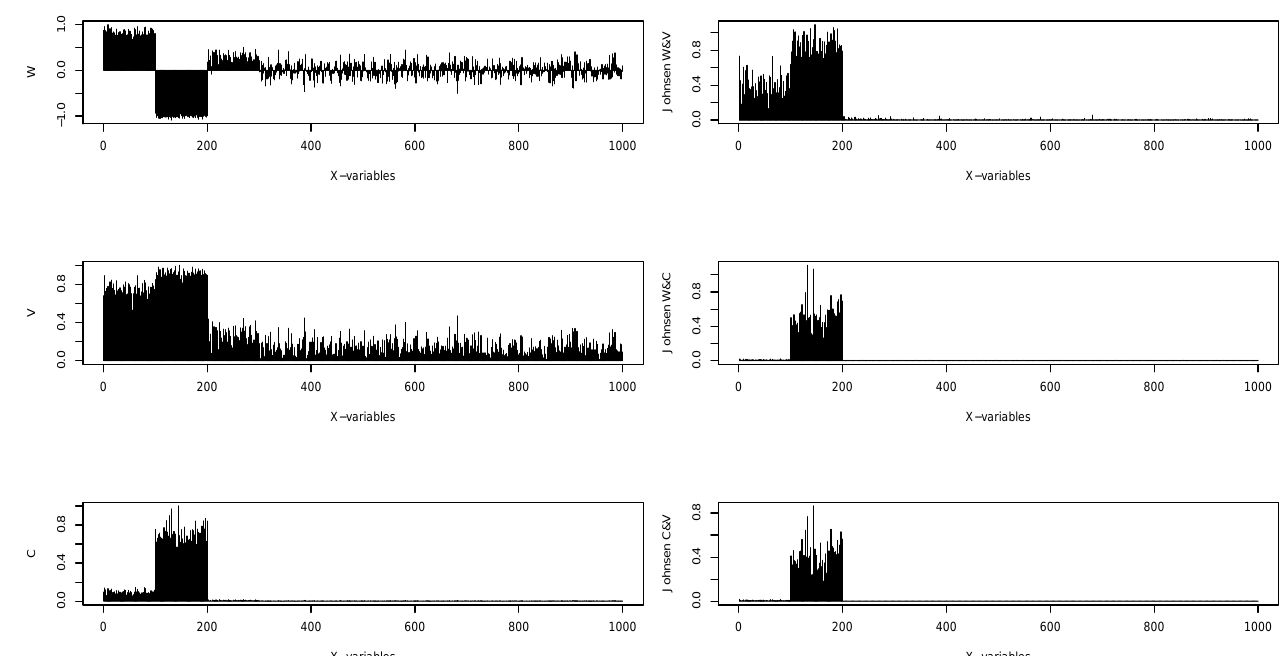
Figure 1. The left panel shows the reference measures loading weights ( W ), variable importance on projection ( V ), and significance multivariate correlation ( C ) extracted from the simulation study, while the right panel shows the proposed measures, which are the Johnsen index as a combination of W , V , and C . The data was generated using a simulation. R 1 = ( 0.75,0.95,0.50,0,0,0,0,0,0, 0 ) and with the correlation between x and y C xy = ( 0.6, − 0.5,0.2,0,0,0,0,0, 0,0 ) , p = 1000 and n = 100.